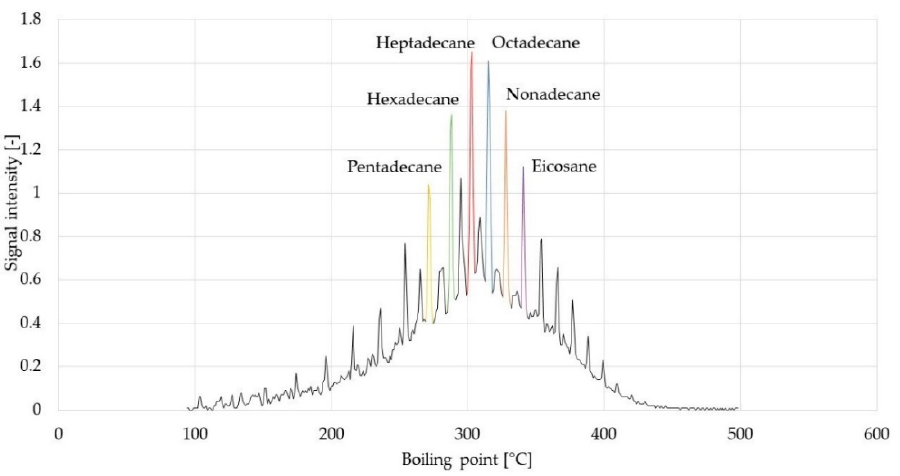
Figure 13. Selected alkanes in the representative average sample prior to the deactivation.